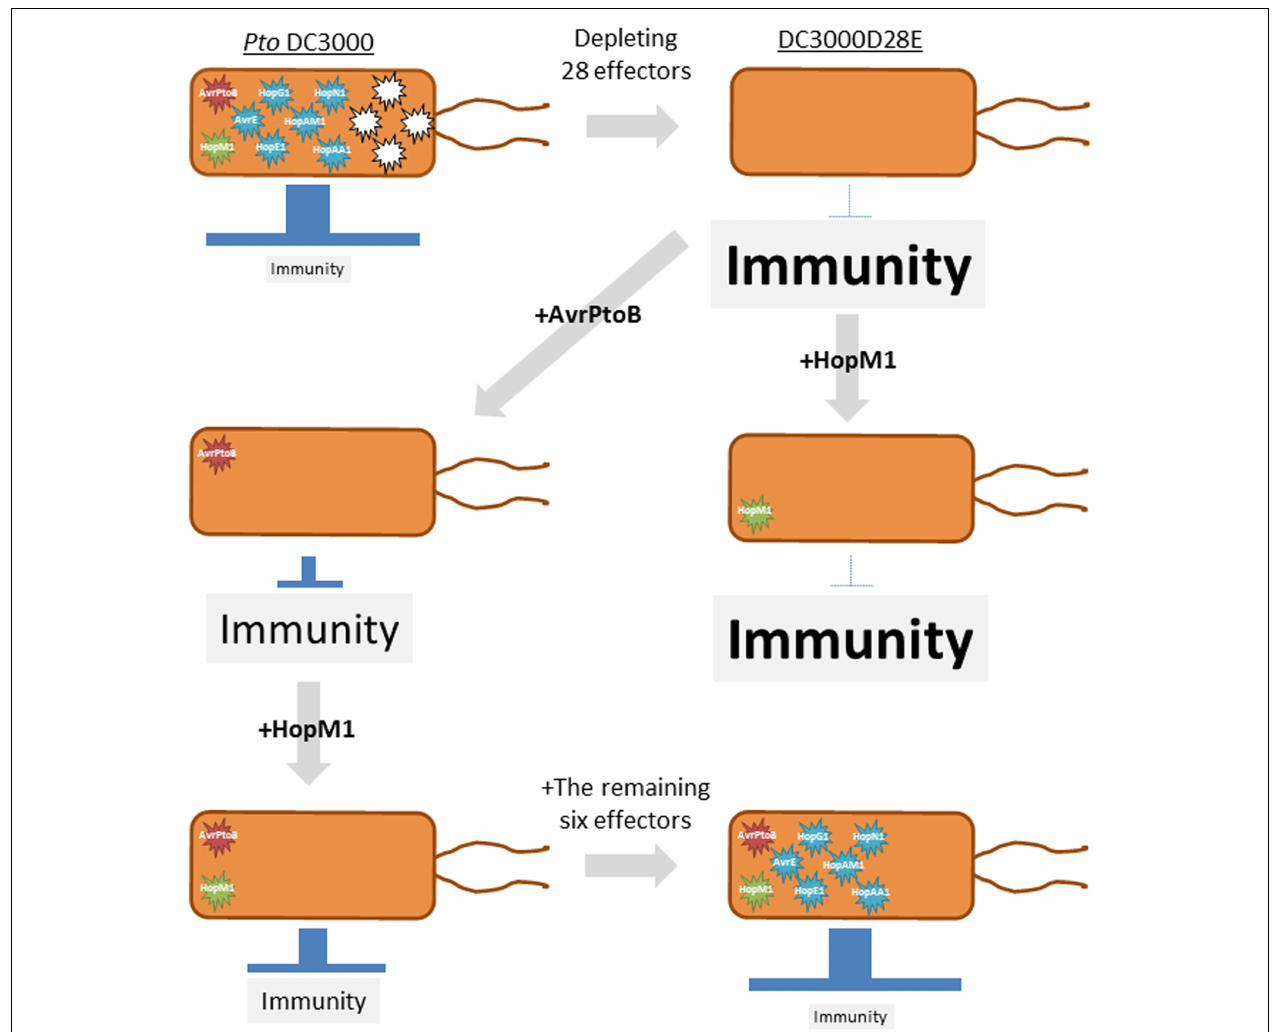
growth. HopM1 requires AvrPtoB to promote bacterial growth. The remaining six effectors (AvrE, HopE1, HopG1, HopAM1, HopAA1, and HopN1) support bacterial growth to near the wild-type level in the presence of AvrPtoB and HopM1. This approach was used in Cunnac etal.